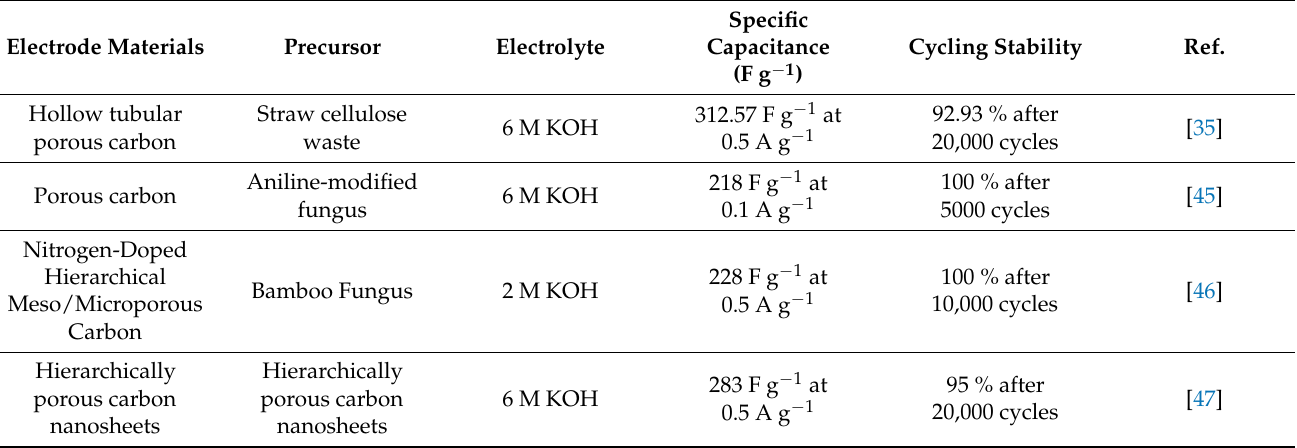
Table 2. Comparison of electrochemical performance of porous carbon materials derived from different